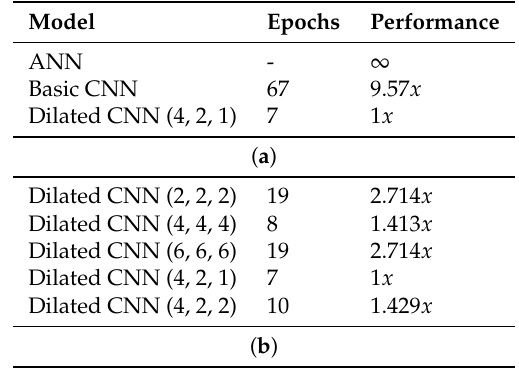
Table 6. Epoch and comparative performance to determine the computational effort required for various the models to reach an acceptable accuracy of above 90%. x is the factor for the minimum time taken to achieve threshold accuracy ( a ) Simple ANN, Basic CNN and Dilated CNN. ( b ) combinations of dilation rates for the different convolution